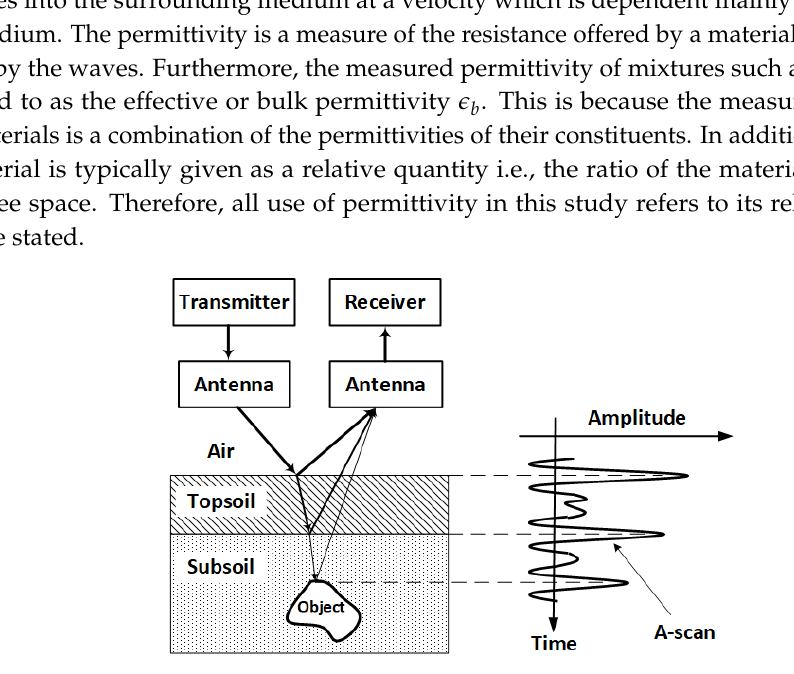
Figure 2. Principles of ground penetrating radar (GPR). Reflected waves from boundaries a recorded by the receiver and displayed as a time varying signal called an